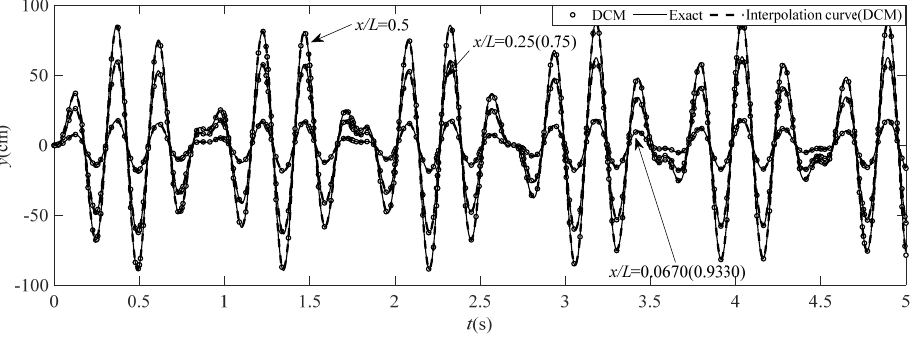
Figure 8. Time-history displacement of beam midpoint (T = 5 s). Table 2. Comparison of DC solution and analytic solution for time-history displacement of Timo- shenko beam.